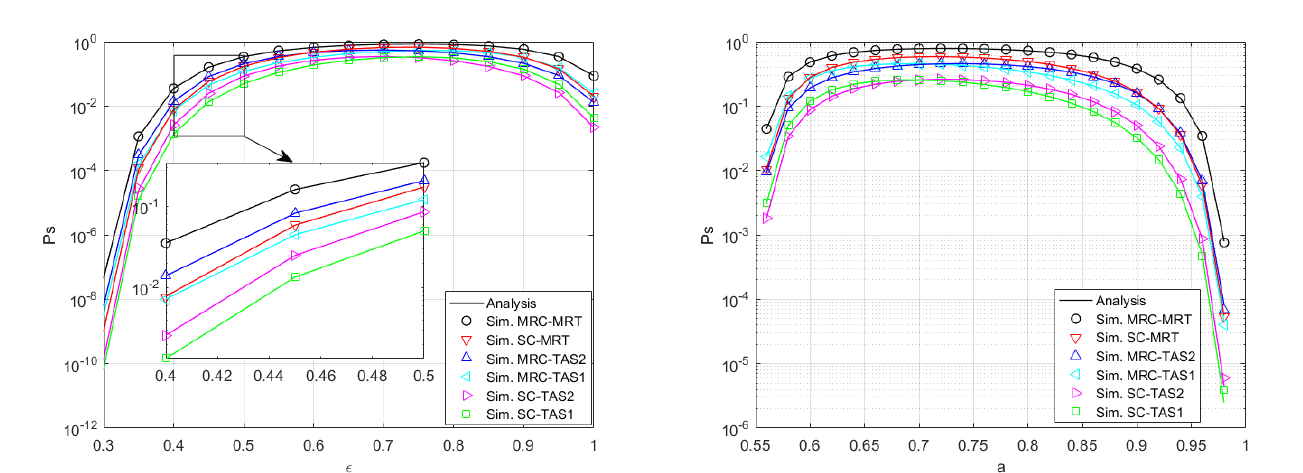
Figure 9. Impacts of the data offloading ratio (cid:15) on Ps of different schemes